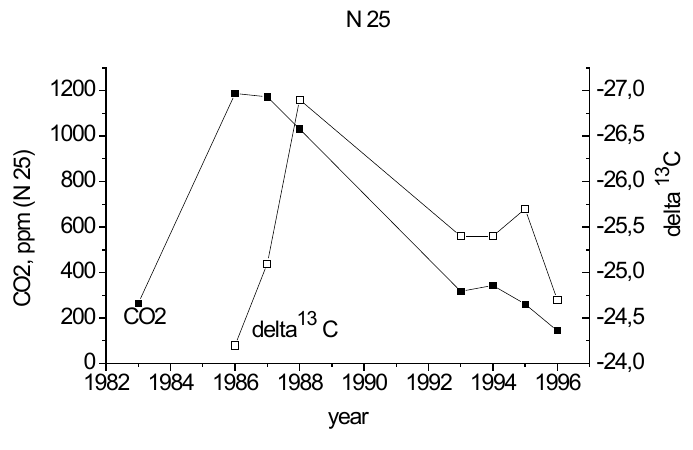
Figure 2. Annual trend of the CO isotope composition (delta 13